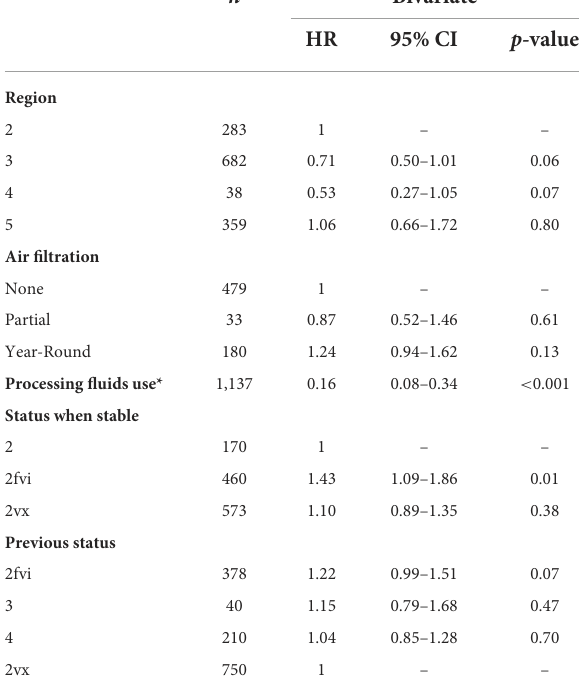
TABLE 1 Bivariate proportional hazards mixed effect survival model results between time to stability and investigated predictors, using production system as a random-effect